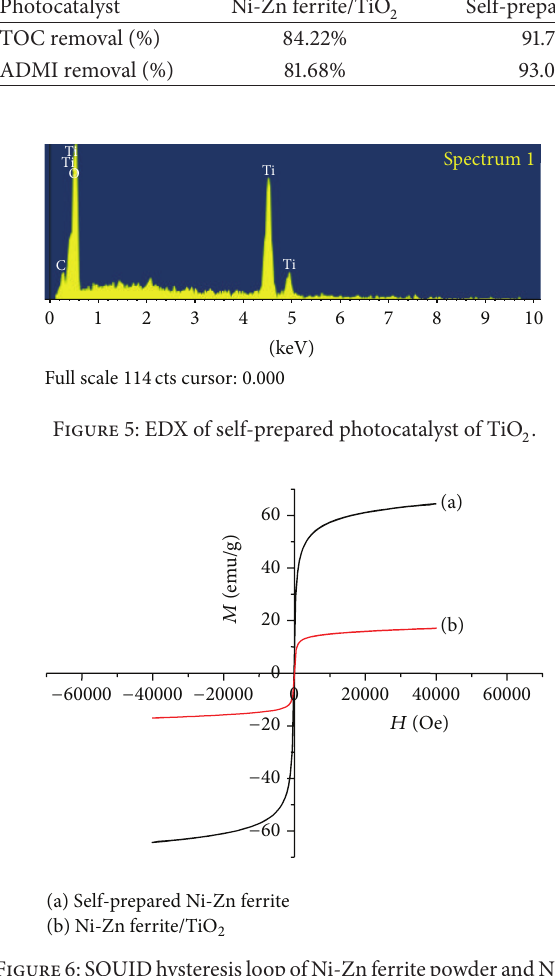
Figure6:SQUIDhysteresisloopofNi-ZnferritepowderandNi-Zn ferrite/TiO 2 calcined at 500 ∘ C.